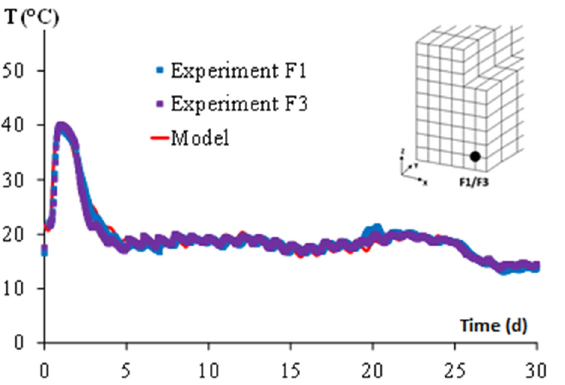
Figure 19. Temperature obtained by the model on inner face on the